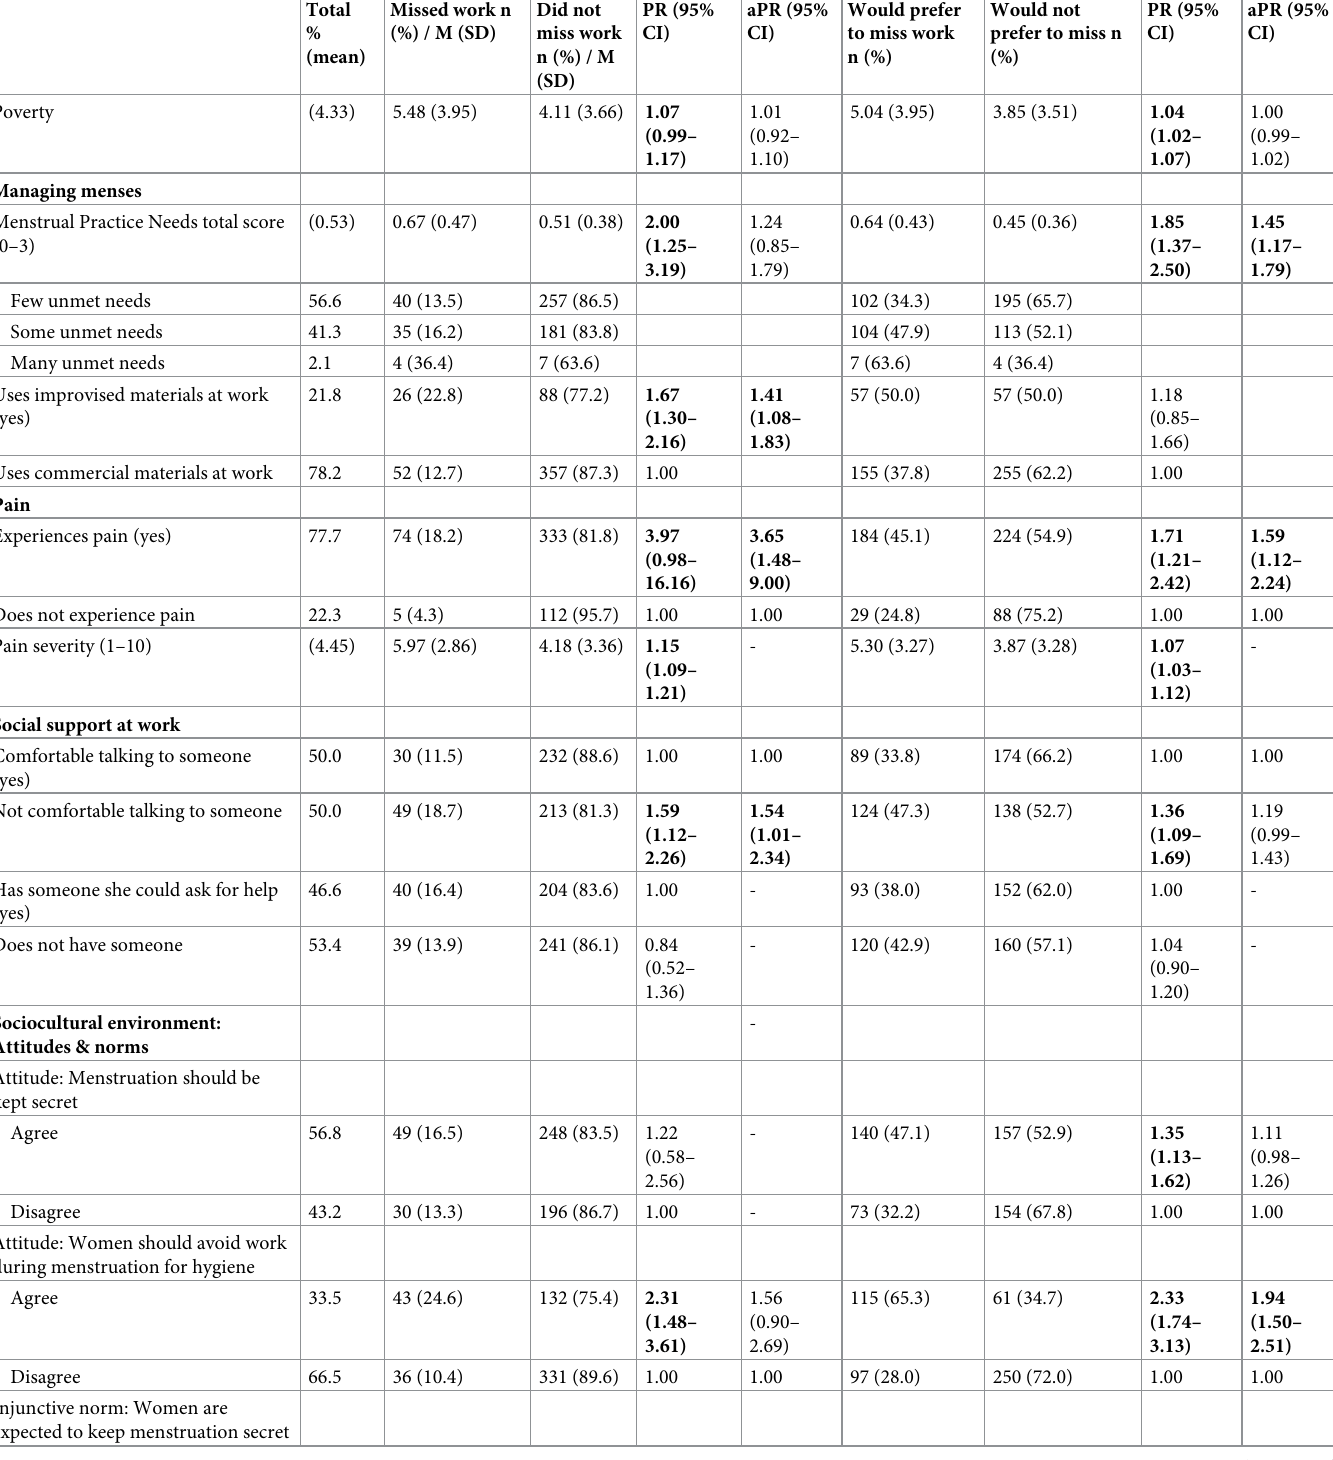
Table 4. Prevalence of menstrual health needs, bivariate and multivariable associations between reported menstrual health needs and work absenteeism and dis- comfort in Mukono, Uganda.